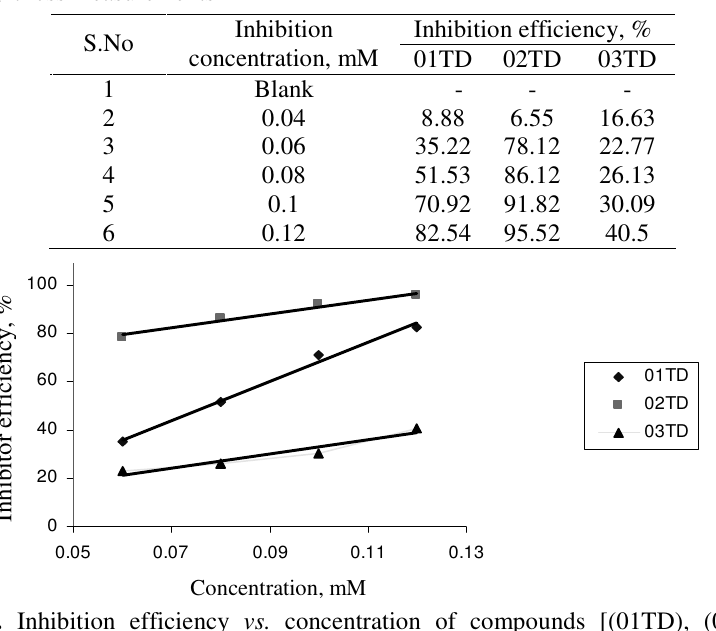
Table 1. Corrosion parameters of (01TD),(02TD) & (O3TD) on mild steel in 1 M H